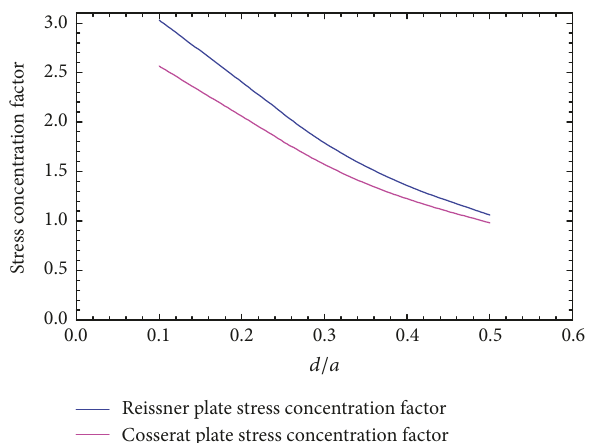
Figure 13: Comparison of the stress concentration factors of the Cosserat plate with Reissner plate for different ratios 𝑑/𝑎 : Cosserat stress concentration factor is smaller than the classical value.